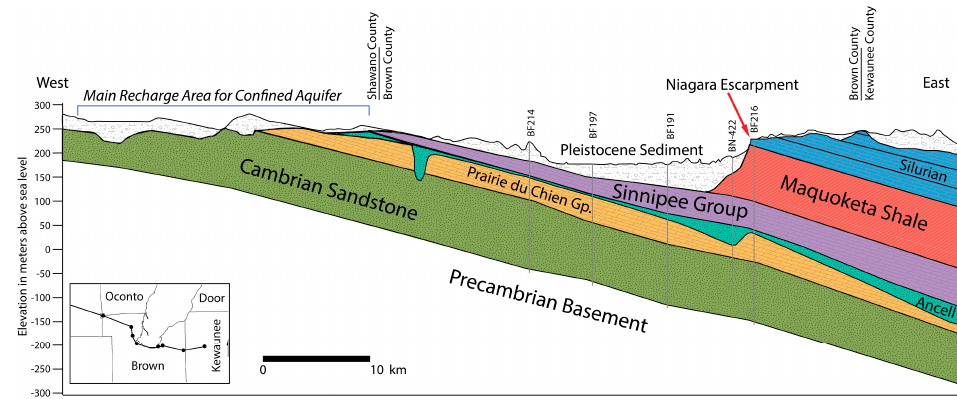
Figure 4. West to east geologic cross-section through portions of Shawano, Brown, and Kewaunee counties near Green Bay, Wisconsin. Paleozoic strata typically dip southeastward between about 5 and 7.5 m/km toward the ancestral Michigan basin. Vertical lines with labels indicate well codes for selected existing and backup wells in the Green Bay region of Brown County. Vertical exaggeration is 45 times. Modified after [13].